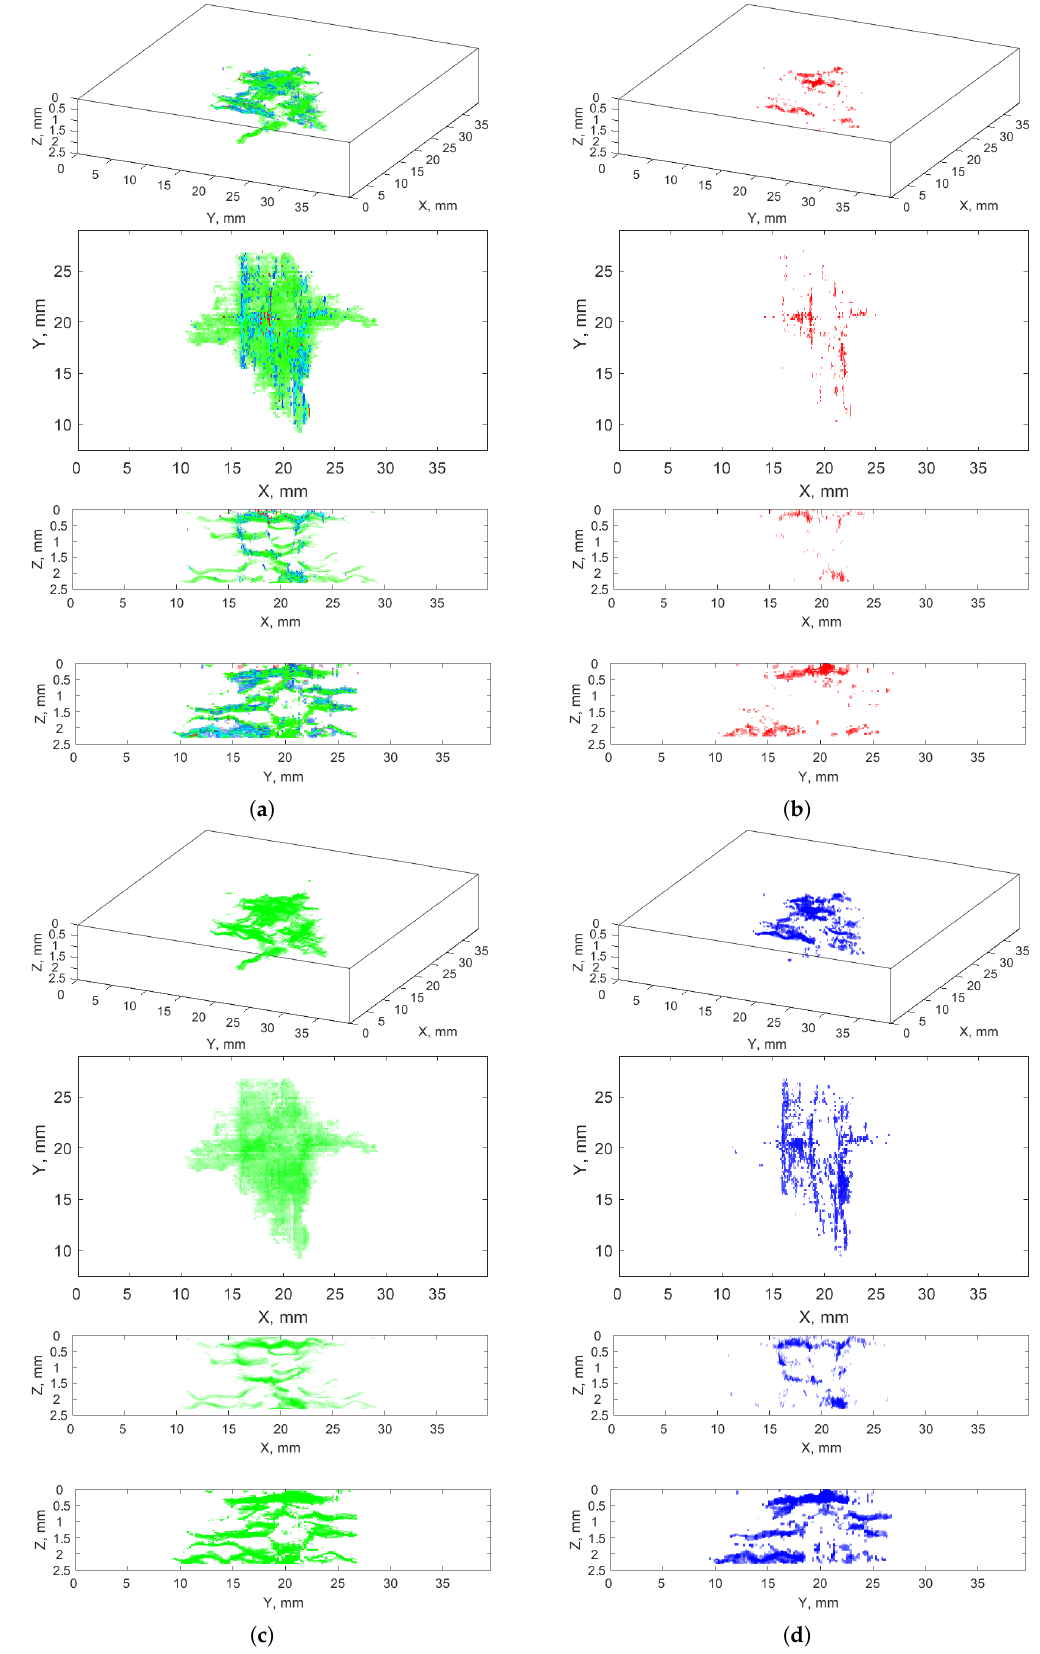
Figure 13. The result of classification of types of cracks resulting from LVI using the proposed method: ( a ) all types of cracks considered in the study, and ( b ) vertical, ( c ) horizontal, ( d ) diagonal